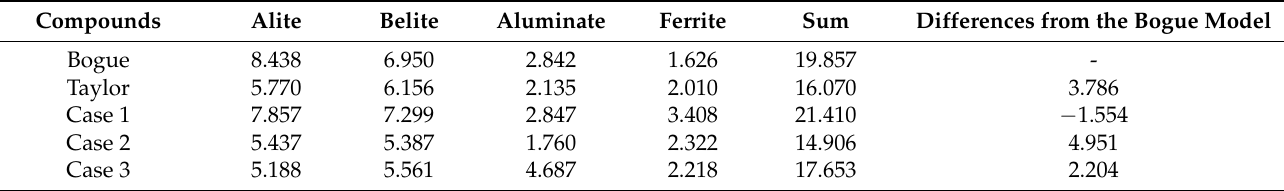
Table 10. Average absolute differences between the experimental data and the results obtained with the Bogue, Taylor, and Case 1–3 models.